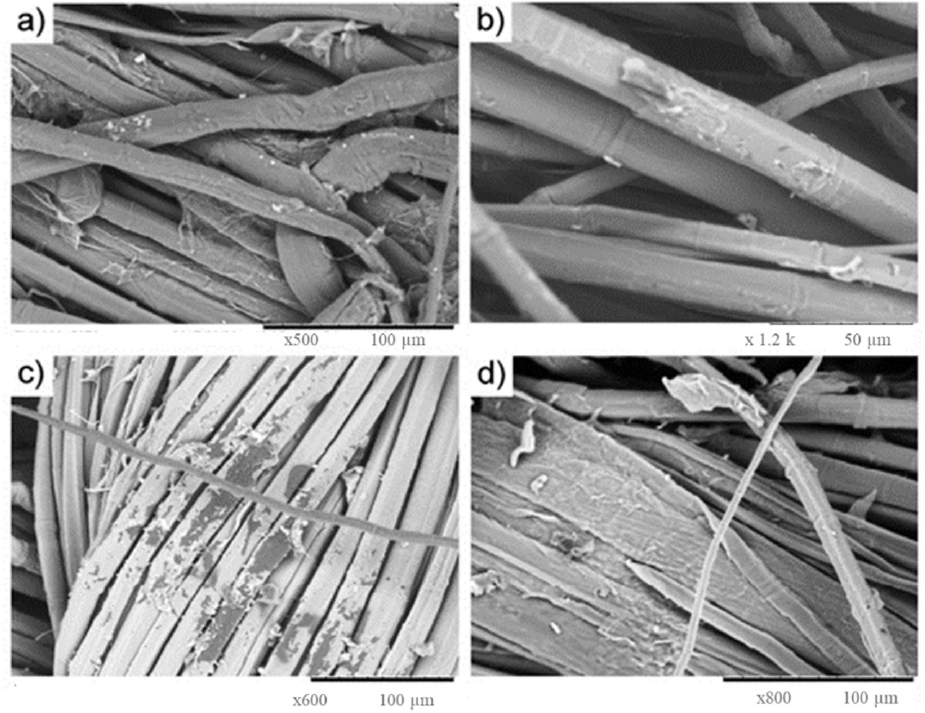
Figure 3. SEM surface images ( a ) untreated, ( b ) 1% silane-treated, ( c ) 5% silane-treated and ( d ) 20% silane-treated hemp fibers (Reproduced with permission from Sepe et al. (2018) [31] ).